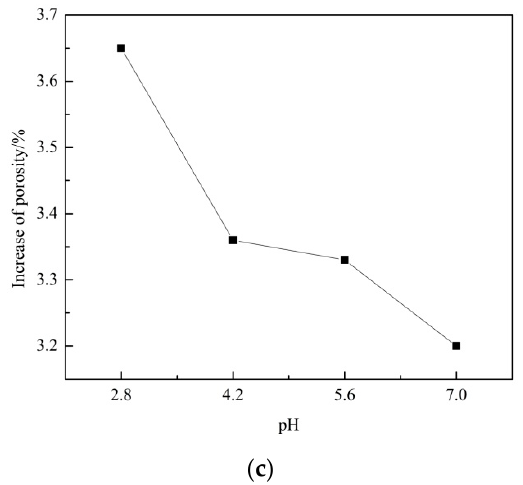
Figure 3. Porosity and pH after different F–T cycles: ( a ) porosity of sandstone after various F–T cycles under different solution, ( b ) pH varies with F–T cycles, ( c ) porosity increase of 10 F–T cycles treated sandstone immersed in solution with different pH.